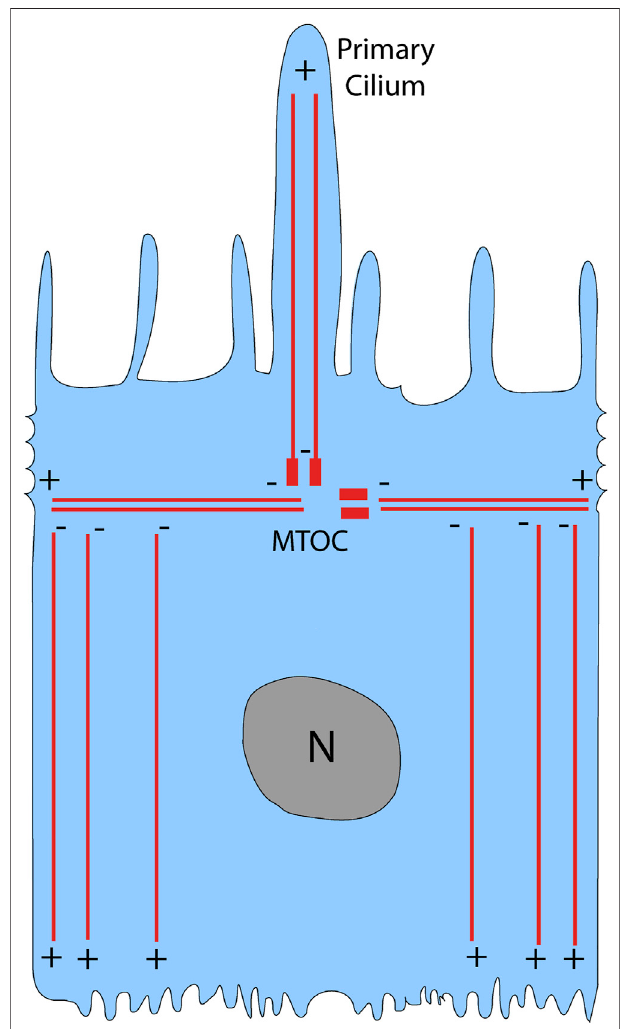
FIGURE 1 | Microtubule organization in the RPE. In a polarized epithelial cell like the RPE, the microtubule-organizing center (MTOC) is located above thenucleus(N),whereitgivesrisetohorizontalmicrotubulesaswellasvertical microtubules that emanate to the primary cilium. The majority of microtubules, however, are non-centrosomal vertical microtubules with their plus-endslocatednearthebasalsurfaceoftheRPE.Modi fi edfromJiangetal.